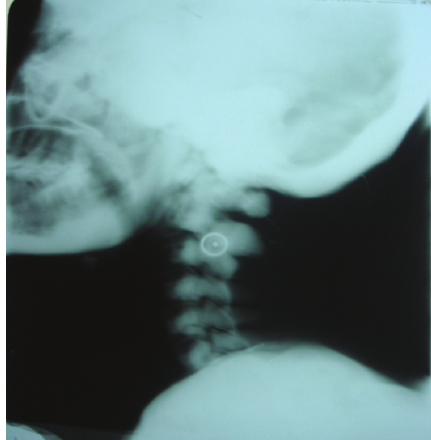
Figure 8: Lateral view of the lumbar spine showing “bone-within- bone appearance.”